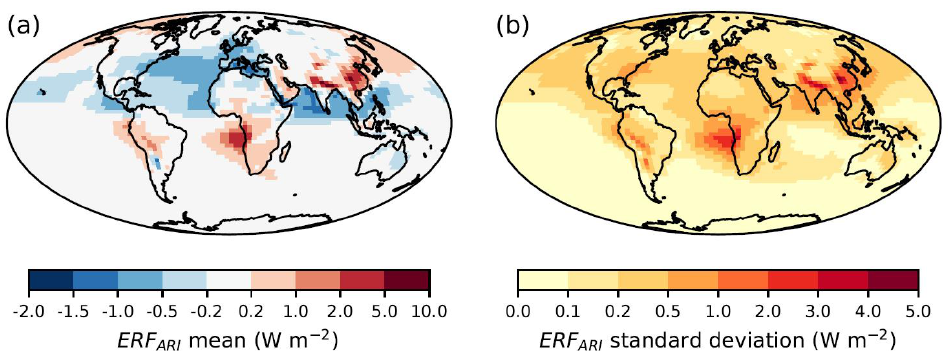
Figure 3. (a) Mean and (b) standard deviation of 1850–2008 ERF ARI forcing. Values were calculated using output from 270000 emulator- derived model variants at the individual pixel level. These samples of model variants are informed by the expert-elicited parameter